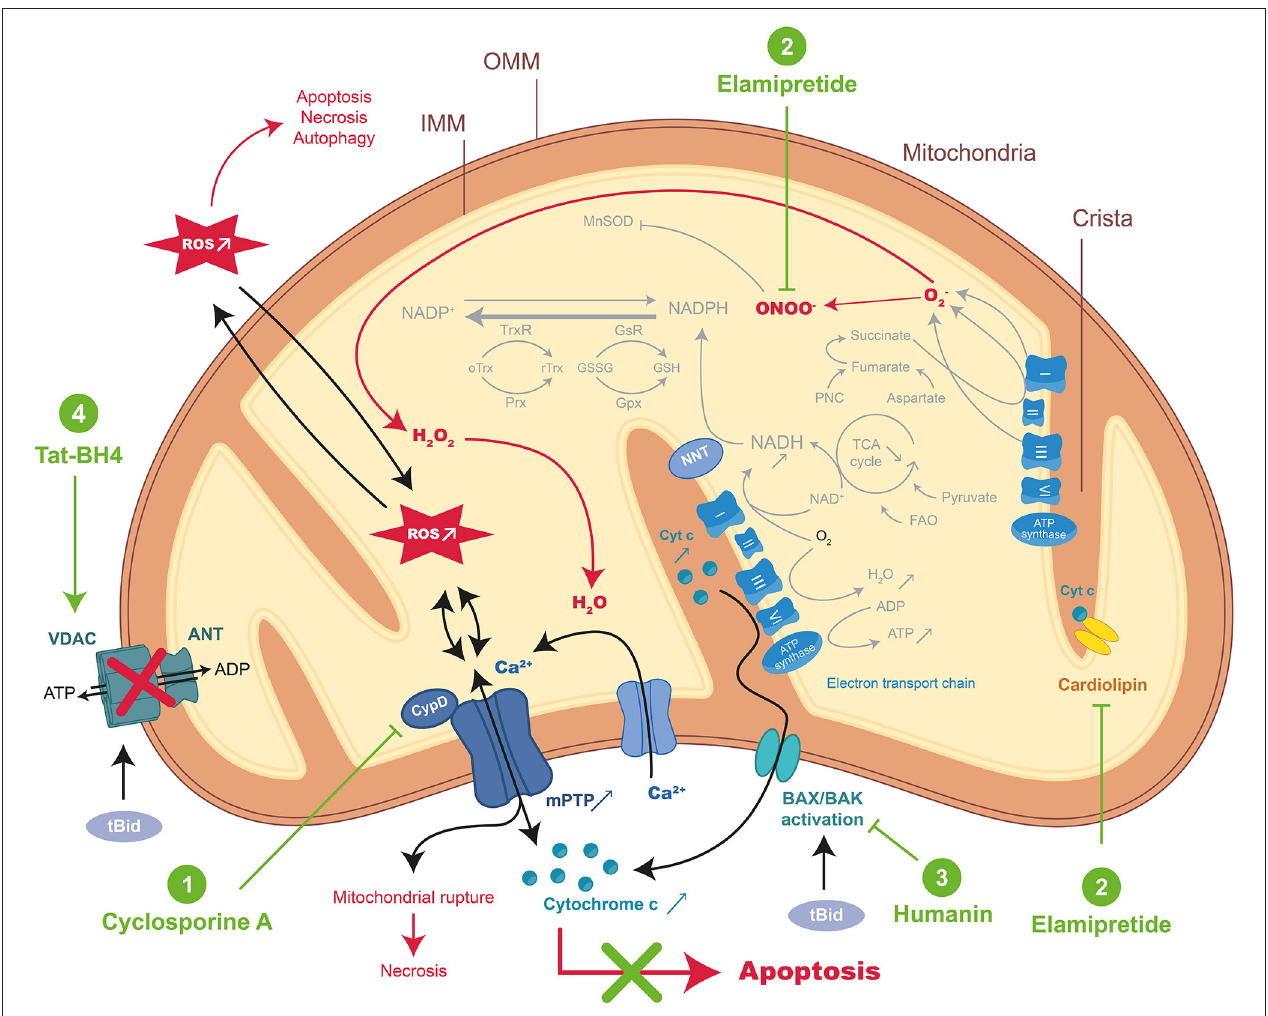
FIGURE 1 | Schematic representation of mitochondrial-dependent apoptosis and mode of action of the therapeutic peptides during MIRI. During acute myocardial ischemia-reperfusion injury (MIRI), reactive oxygen species (ROS) burst and mitochondrial Ca 2 + overload activate regulated cell death (RCD) resulting in apoptosis or necrosis through the mitochondrial permeability transition pore (mPTP) opening. Excessive ROS induced important changes in normal mitochondrial structure and function resulting in the disorder of mitochondrial metabolic function. Therapeutic peptides reducing intrinsic apoptosis during MIRI were highlighted in green: (1) Cyclosporine A (CsA), (2) Elamipretide, (3) Humanin, and (4) Tat-BH4. CypD, cyclophilin D; NNT, nicotinamide nucleotide transhydrogenase; FAO, fatty acid β -oxidation; Prx, peroxiredoxins; Gpx, glutathione peroxidase; GsR, glutathione reductase; Trx, thioredoxin; TrxR, thioredoxin reductase; GSH, glutathione; GSSG, oxidized glutathione; PNC, purine nucleotide cycle; tBid, truncated form of BH3 Interacting domain Death agonist; BAX, BCL2 associated X Apoptosis regulator; BAK, BCL-2 Antagonist/Killer 1; OMM, outer membrane, IMM, inner